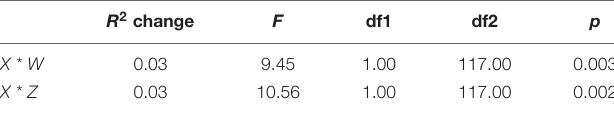
TABLE 10 | R 2 increase due to interaction: WtWE (turnover intentions).